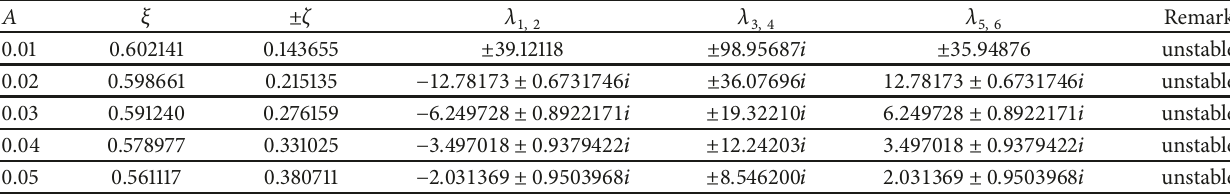
Table 2: Effects of oblateness of PSR 1903+0327 on the locations and stability of out-of-plane points for 𝑎 = 0.95, 𝑒 = 0.437, 𝜎 1 = 0.03 and 𝜎 = 0.015. 2